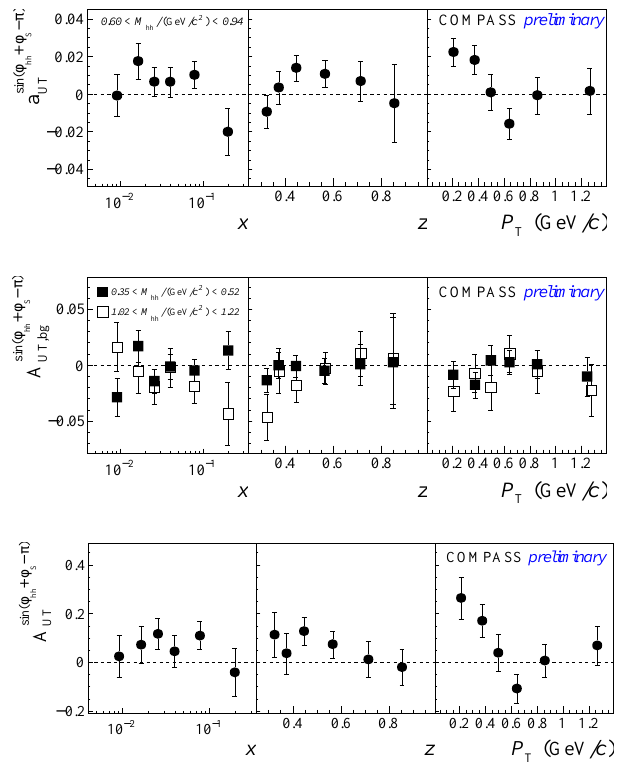
Figure 3: Upper panel: Collins asymmetry in region I I as function of x (left plot), z (middle plot) and P (right plot). Middle panel: corresponding asymmetries in T region I (full points) and I I (open points). Lower panel: final Collins asymmetry for ρ 0 mesons. The errorbars show the statistic uncertainties only. The systematic = 0.3 σ uncertainties for the ρ 0 asymmetry have been estimated to be σ sys stat